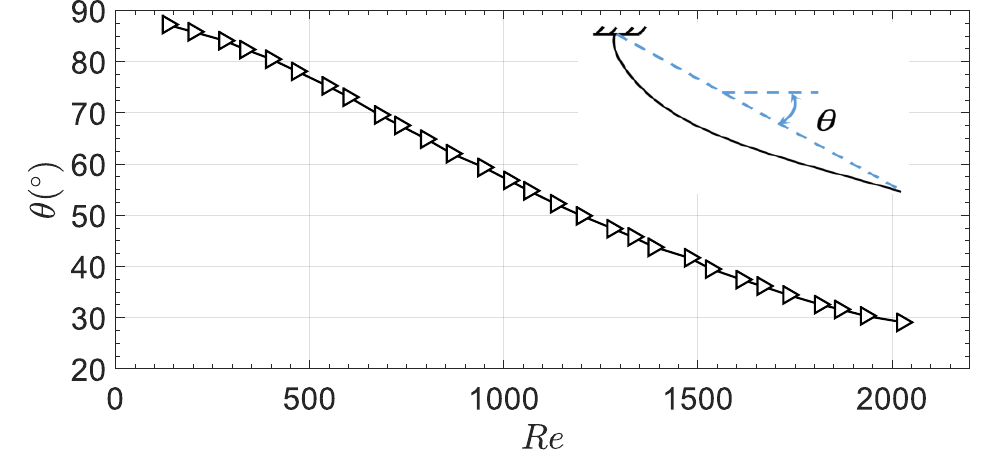
Figure 10. Static deflection angle θ for Filament 6 vs. Reynolds number.